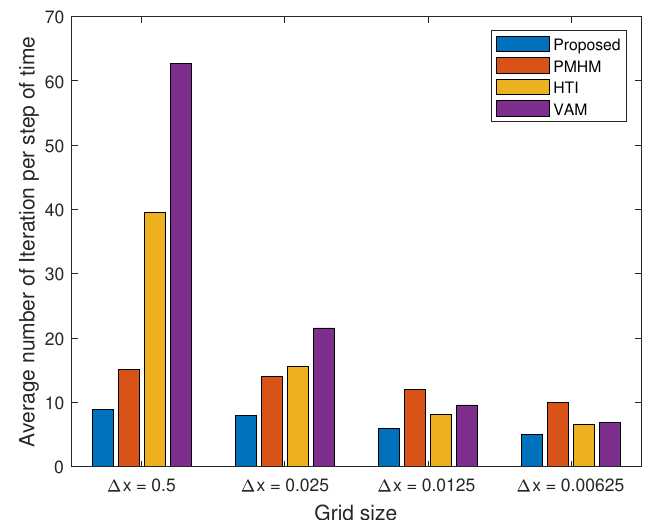
Figure 10. The average number of iterations for the proposed methods and the PMHM, HTI, and